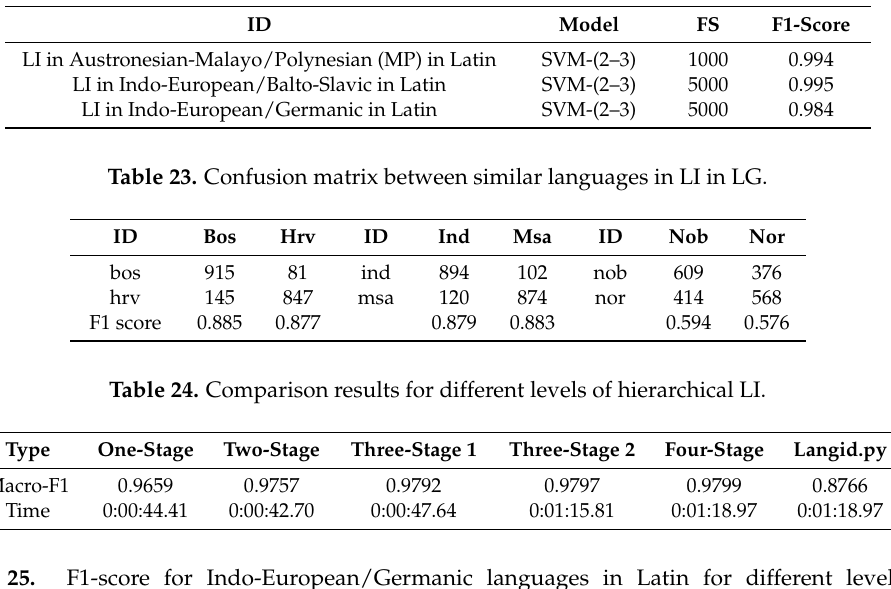
Table 25. F1-score for Indo-European/Germanic languages in Latin for different levels of hierarchical